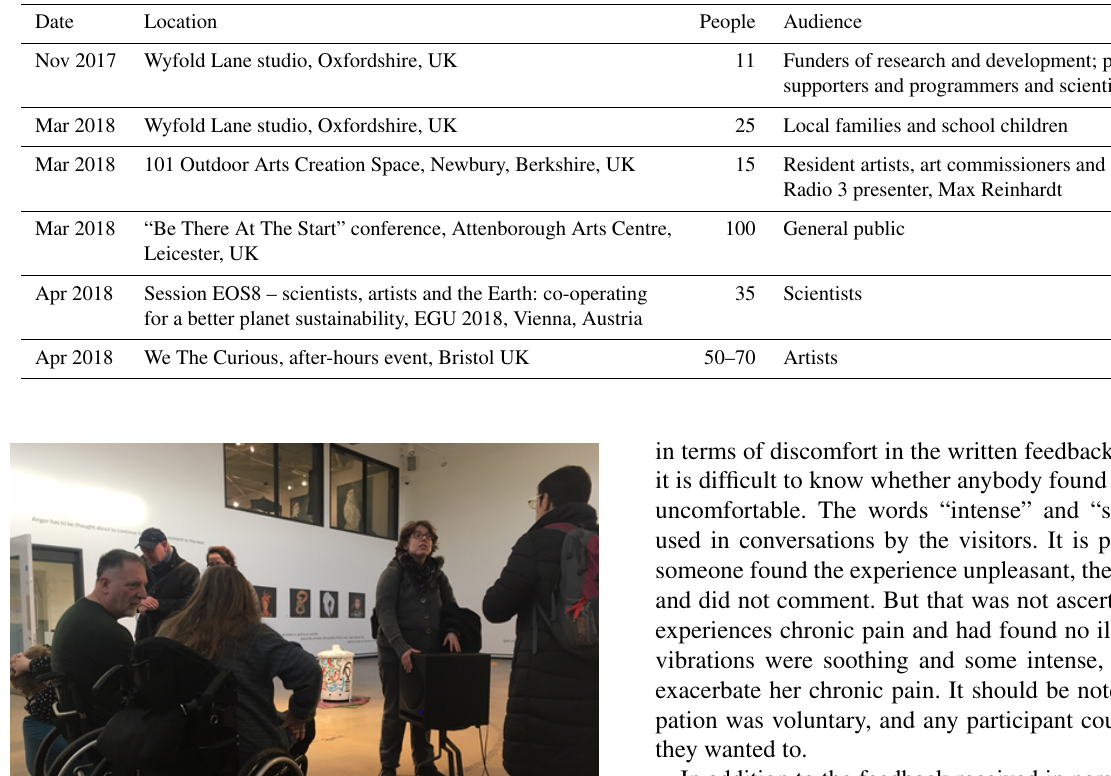
Table 1. List of public engagement activities where the hertz prototype were shown.